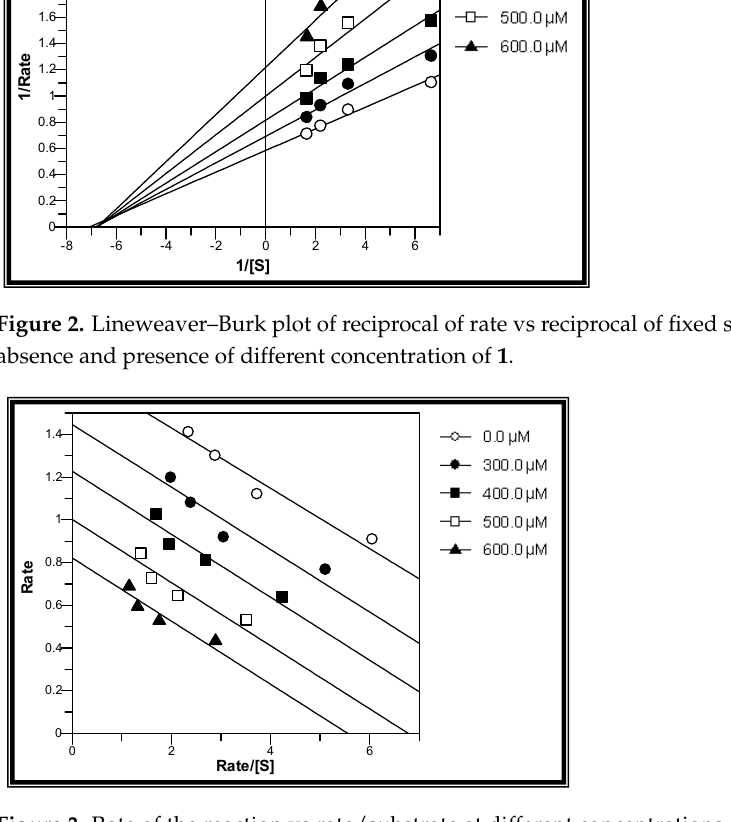
Figure 3. Rate of the reaction vs rate/substrate at different concentrations of 1.